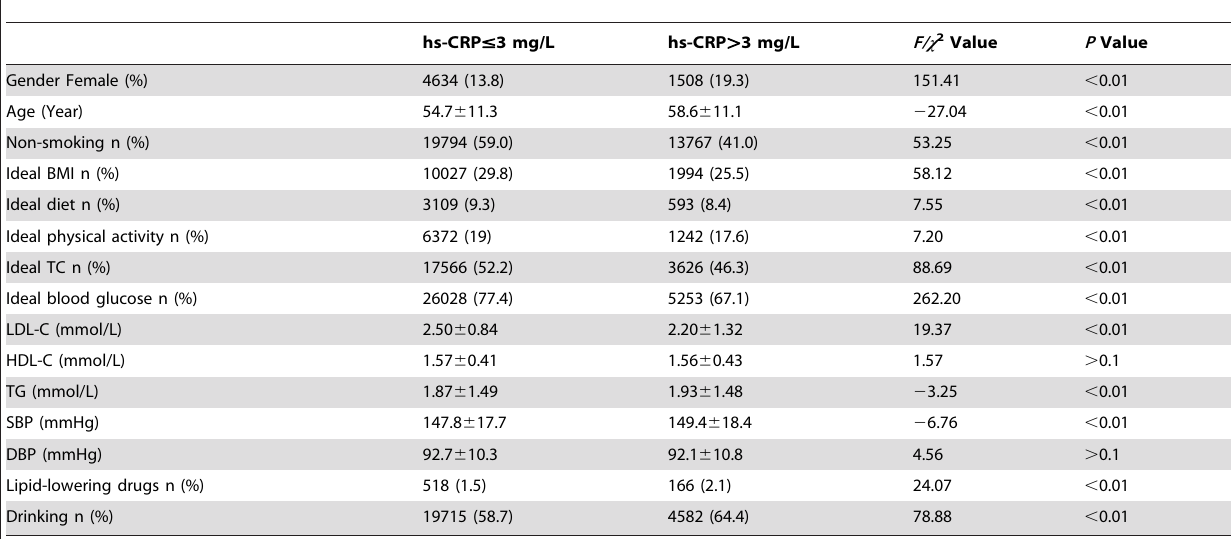
Table 1. The baseline Characteristics of the hypertensive population.